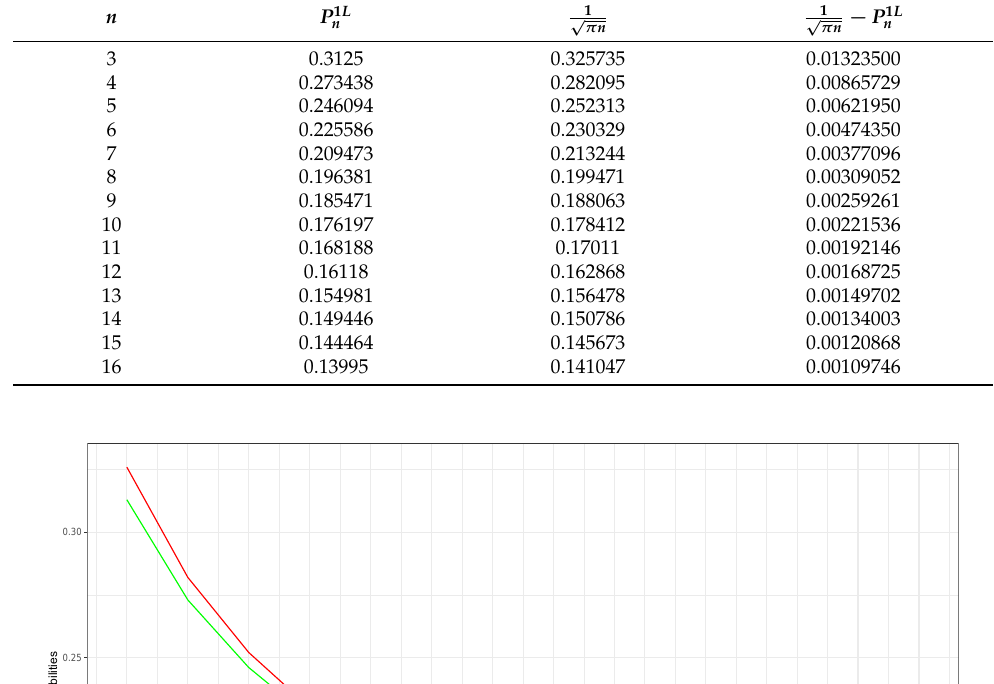
∼ 0.2734 > 0.225 = P 1 4